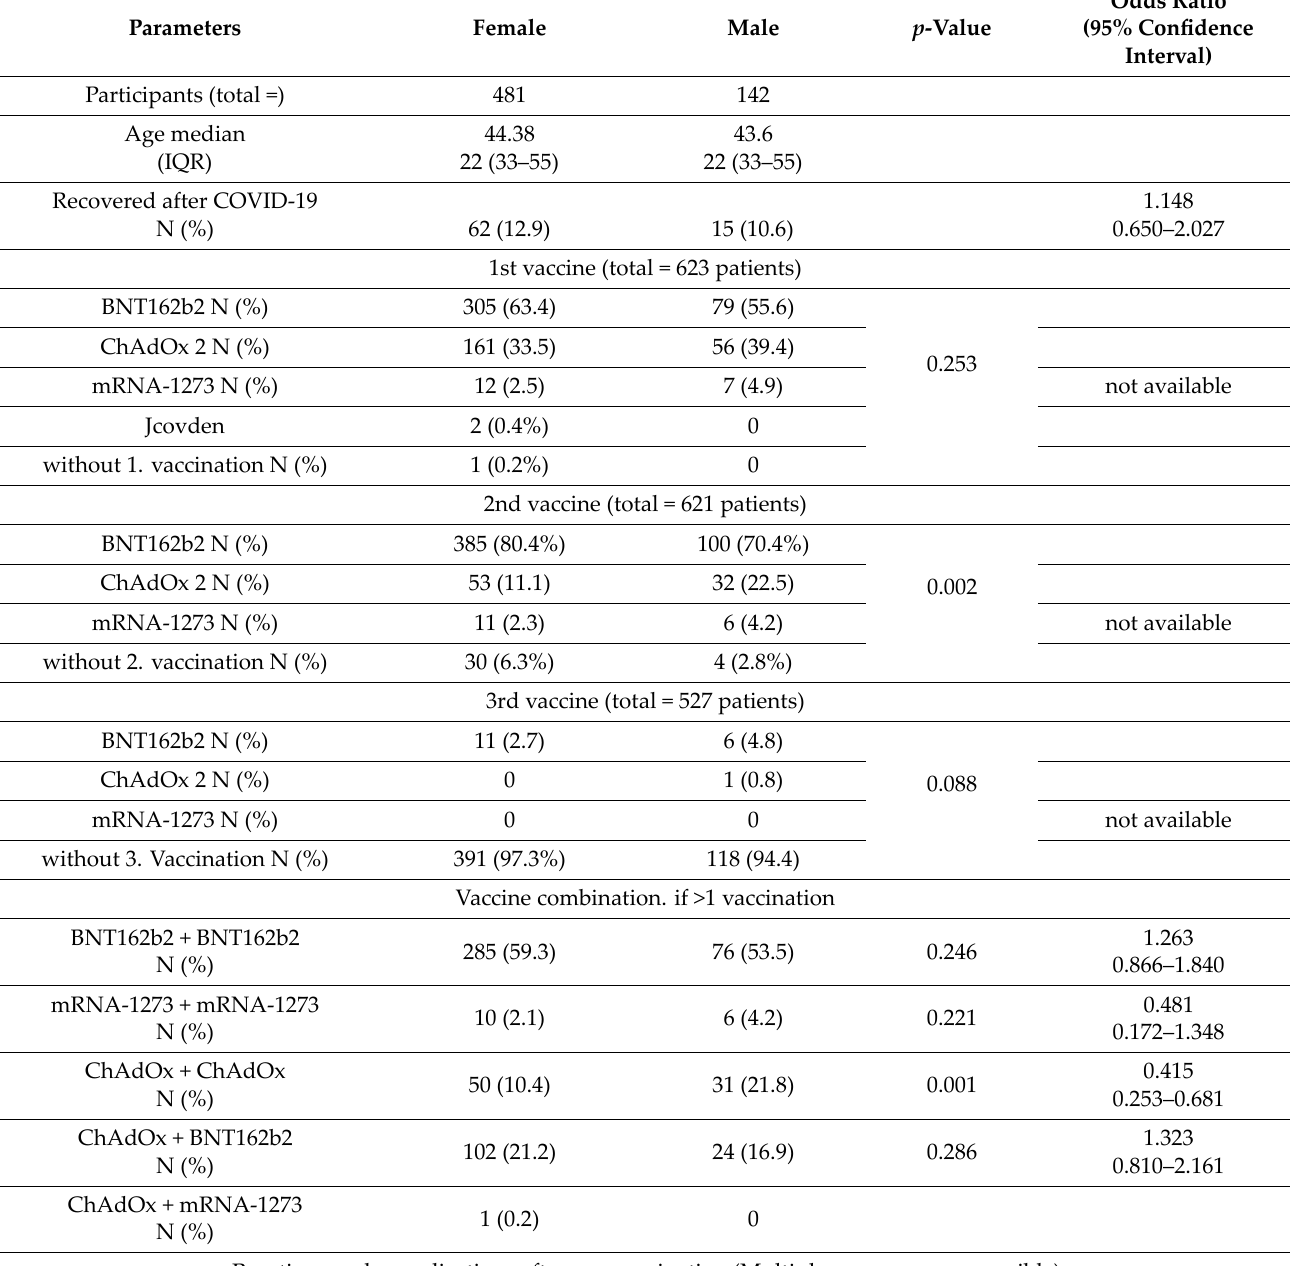
Table 2. Baseline